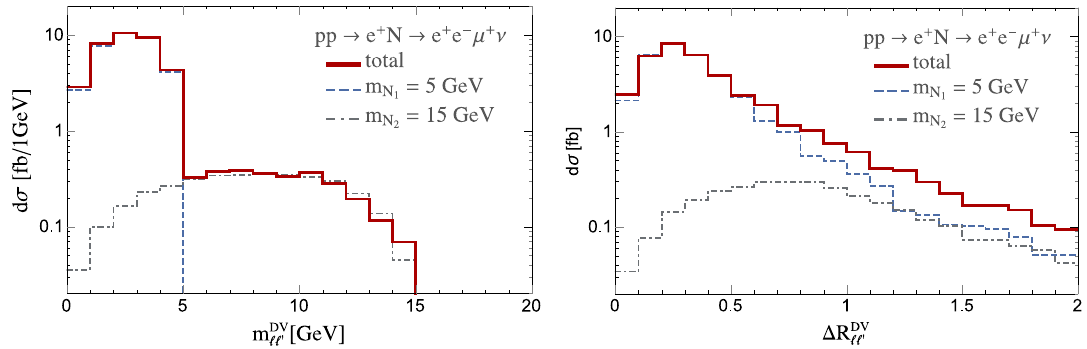
Figure 9 . Invariant mass m DV the DV for a 3+2 model with m N Dashed lines are for the 3+1 model for each HNL, while red is the total in the 3+2. Cuts on the prompt lepton of p e +